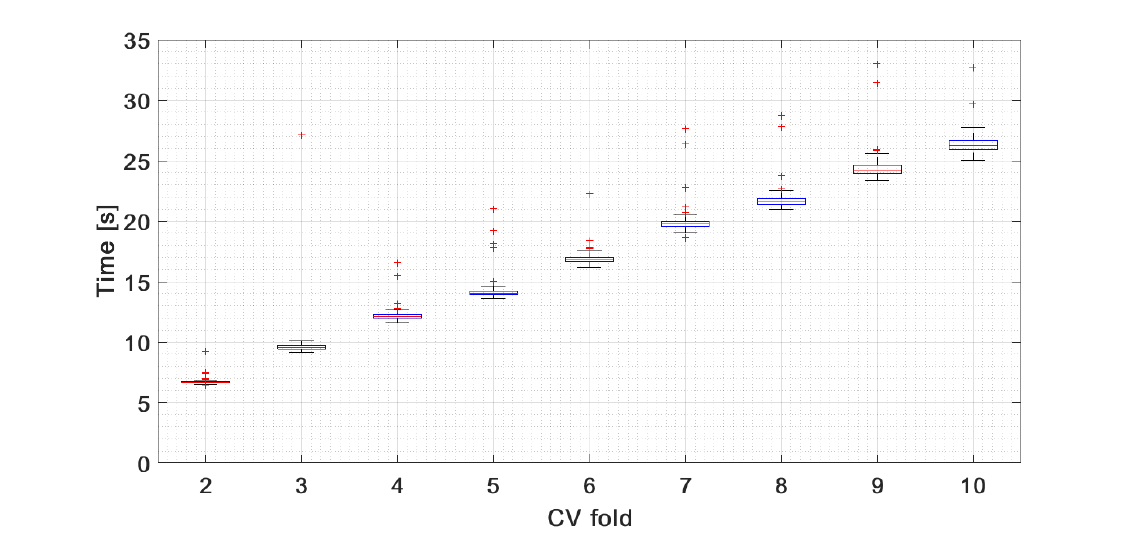
Figure 9. Time-training statistics (box plots) obtained for the adaptive KSVM versus the number of CV folds. The test was performed at 35 PCs and 30 initialization points in the NM algorithm.